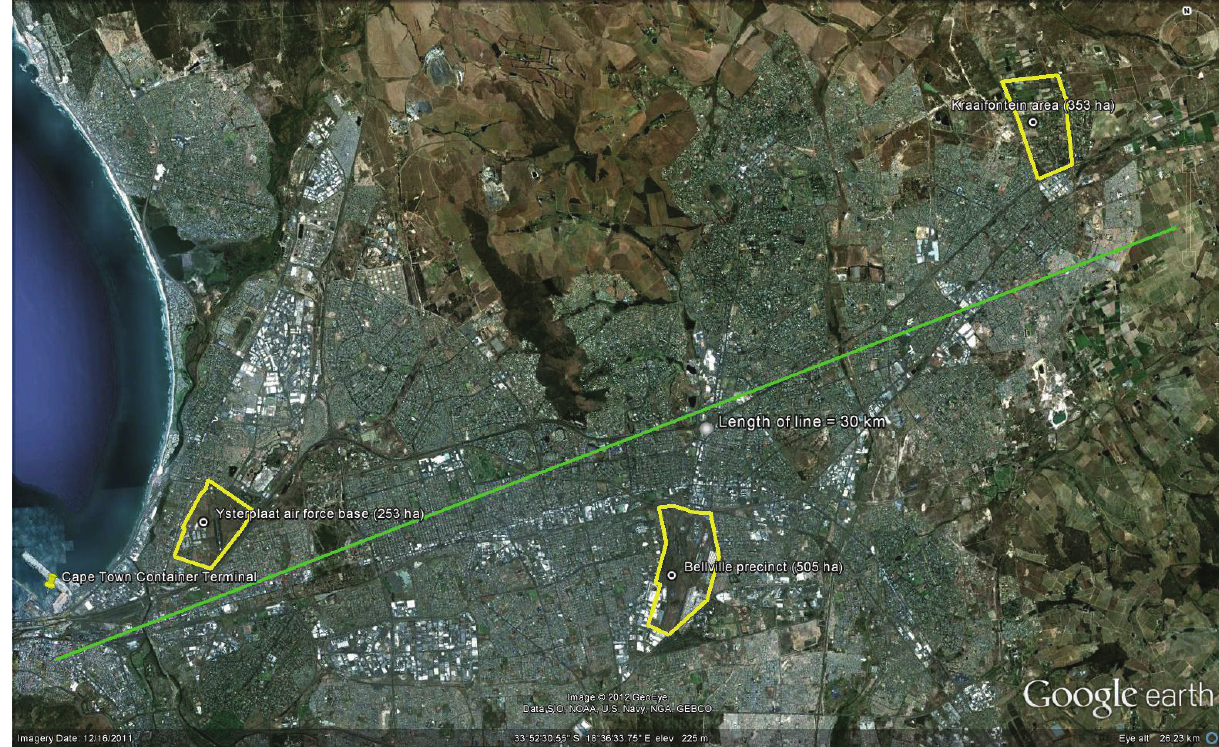
Figure 4: Location of the three potential sites in relation to the Port of Cape Town